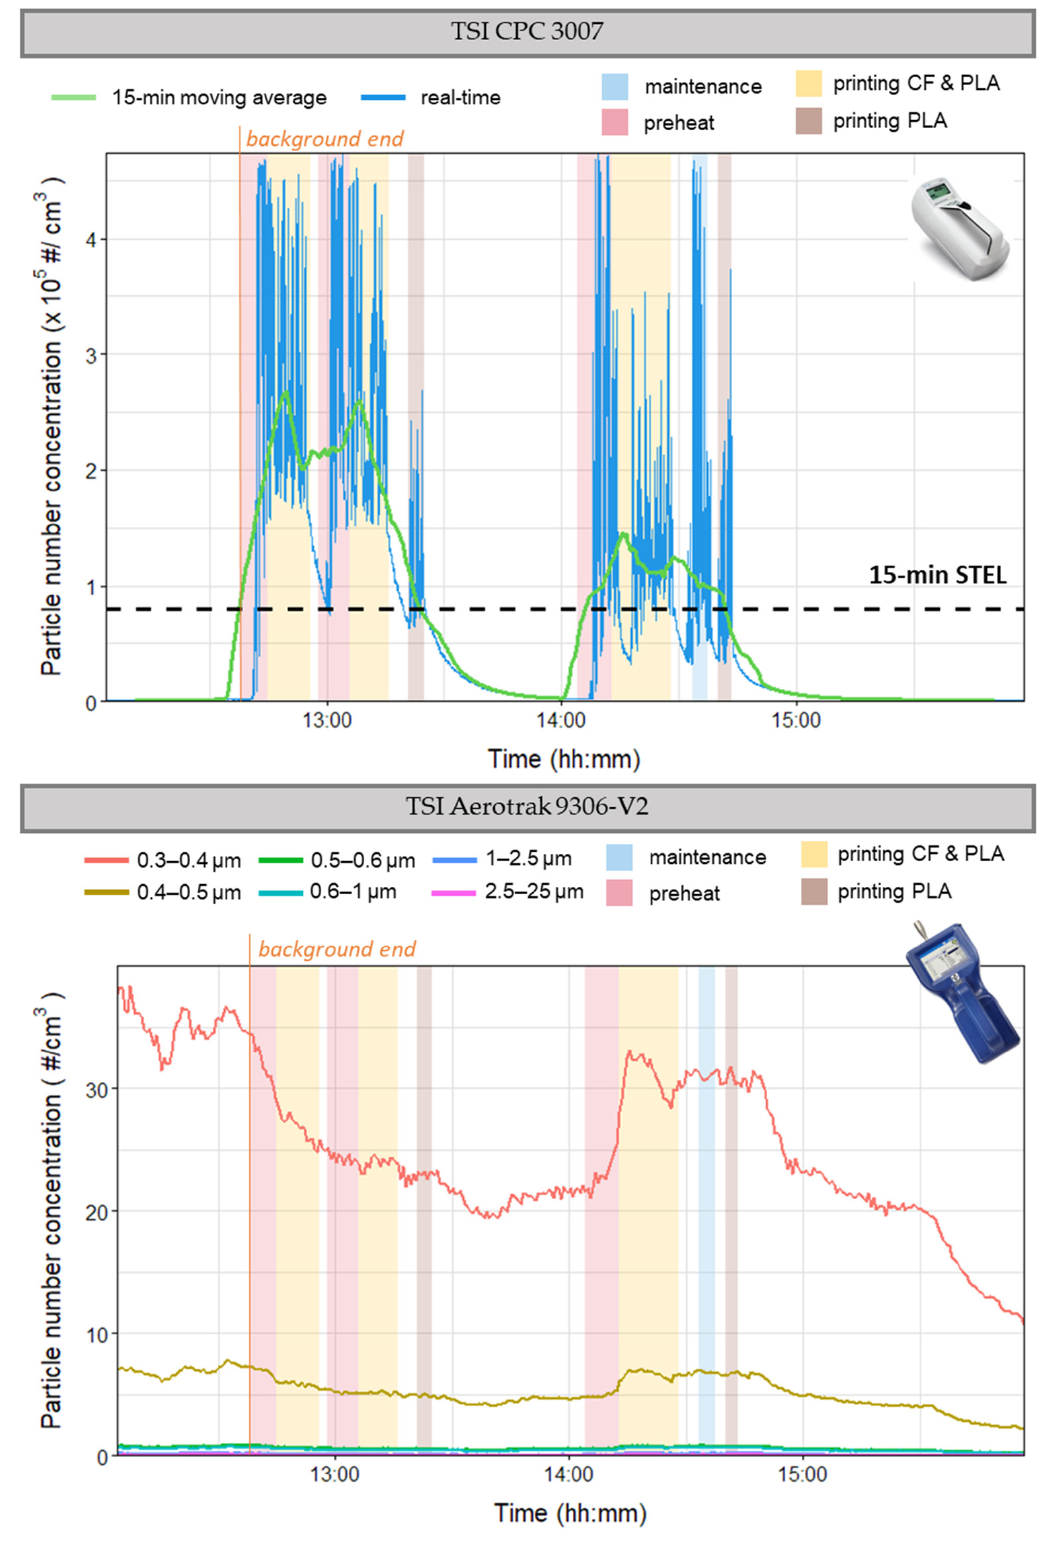
Figure 7. Particle concentrations for Case 4a.